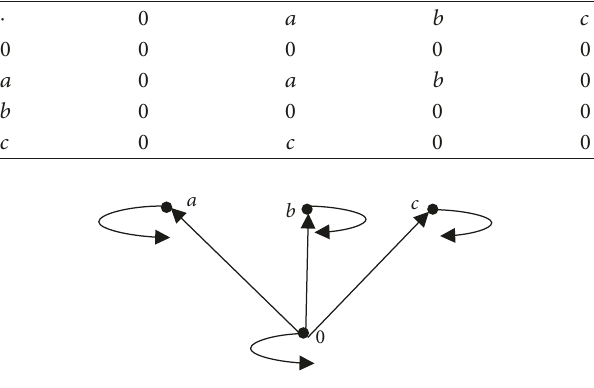
Figure 2: Order relation of 𝑆